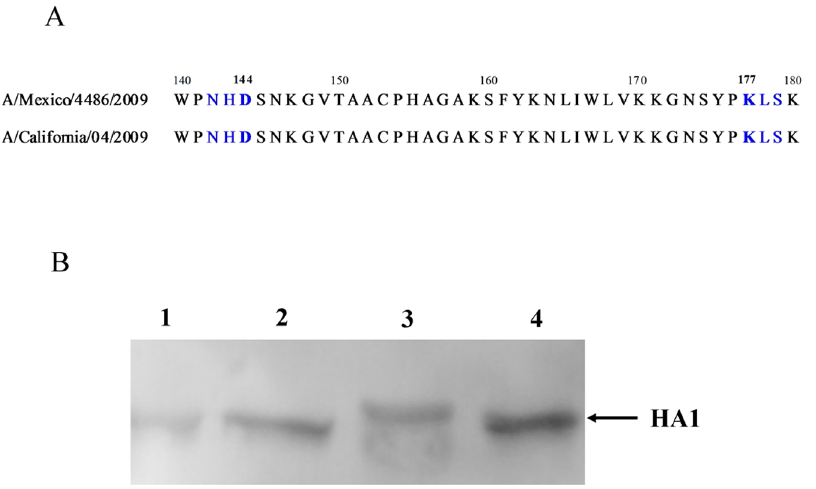
Figure 1. HA sequence alignment and examination of glycosylation. (A) The HA protein sequence alignment of pandemic H1N1/2009 virus. (B) Examination of glycosylation of the H1N1 HA proteins by Western blotting. 1: H1N1/144, 2: H1N1/177, 3: H1N1/144 + 177 and 4: H1N1/WT.